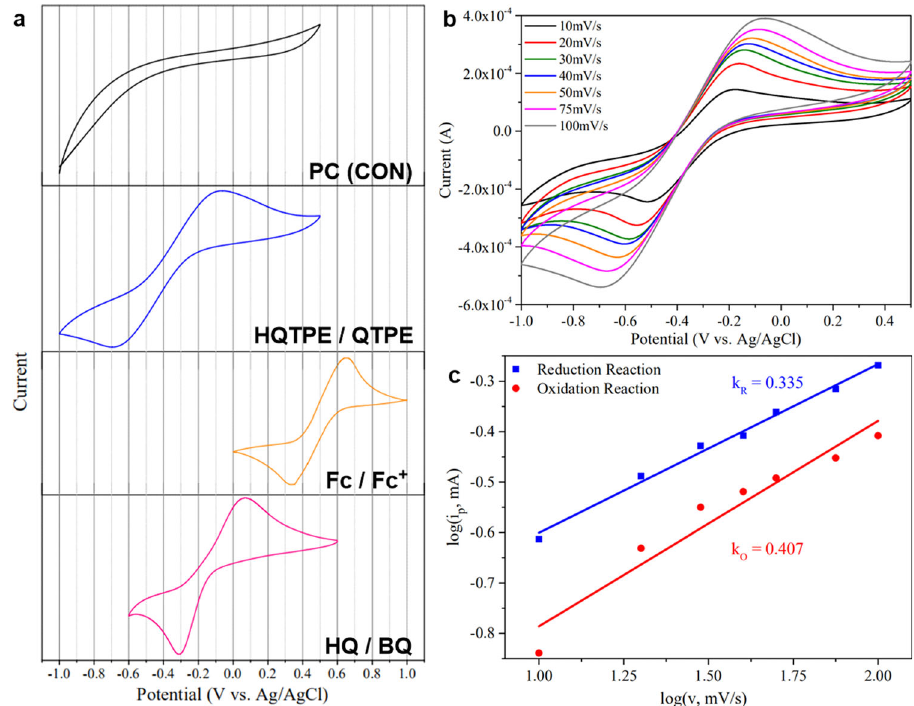
Fig. 7 Electrochemical performance of HQTPE. a CV curves of HQTPE and other reference substances: pure PC, unsubstituted ferrocene, and p -hydroquinone at a scanning rate of 100 mV s − 1 . b CV curves of HQTPE at different scan rates. c Corresponding log i